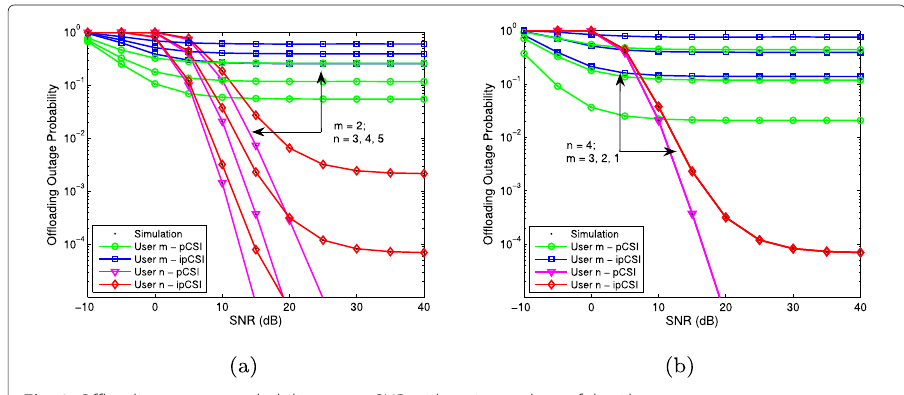
Fig. 8 Offloading outage probability versus SNR with various values of the i th user